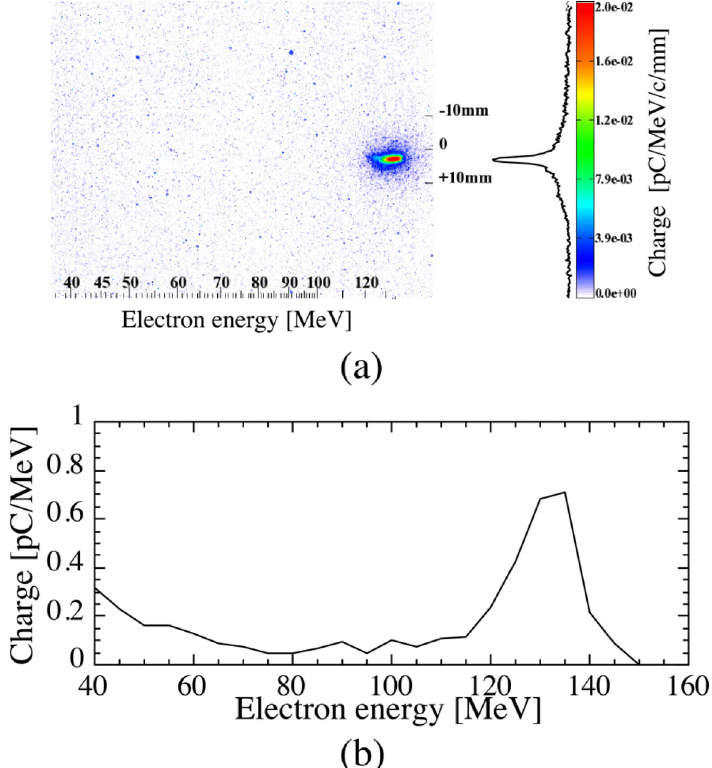
Figure 14. ( a ) A typical image of an energy distribution of the electron bunch at = 1.0 × 10 19 cm − 3 , and a projection of the image onto the energy axis; ( b ) The n e monoenergetic electron bunch has a peak energy of 134 MeV and an energy spread of